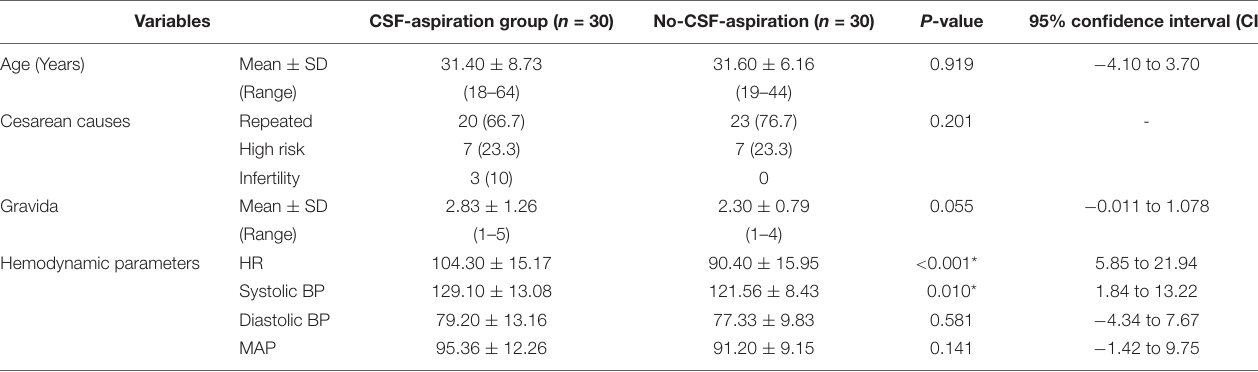
Figure 1 . Eighty physical status I–II ASA term